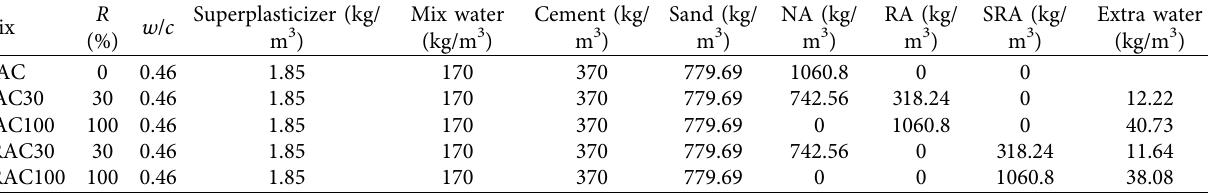
Table 5: Mixing proportion of different concretes.